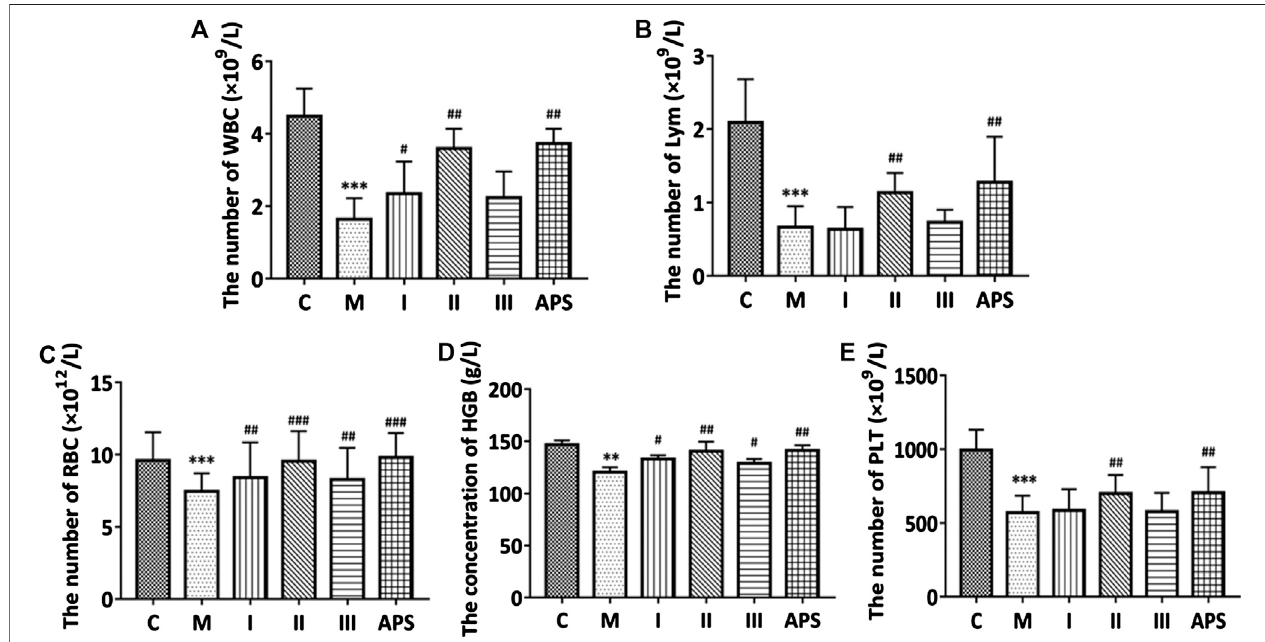
FIGURE 4 | Comparison of the routine blood indices of each group. White blood cells (A) , lymphocytes (B) , red blood cells (C) , hemoglobin (D) , platelets (E) . C : controlgroup,M:modelgroup,I:APS-I,II:APS-II,III:APS-III.n (cid:2) 6, ± s ,* p < 0.05,** p < 0.01,*** p < 0.001 vs .thecontrolgroup; # p < 0.05, ## p < 0.01, ### p < 0.001vs.the model group.